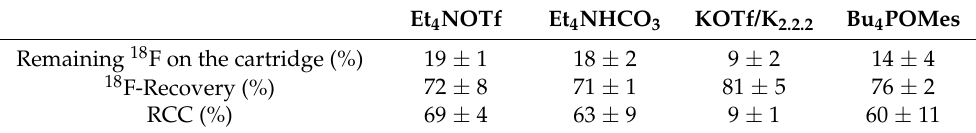
Table 1. 18 F-Recovery and radiochemical conversions (RCCs) of [ 18 F]FPh using different salts in n BuOH. Conditions: [ 18 F]Fluoride (~50 MBq) was loaded onto a QMA cartridge from the male side. The cartridge was washed with n BuOH (1 mL) in the same direction and flushed with air (5 mL). Afterwards 18 F – was eluted from the female side with a solution of the respective salt (11 µ mol) in n BuOH (300 µ L). A solution of PhSnMe 3 (14.5 mg, 60 µ mol) and Cu(py) 4 (OTf) 2 (20.3 mg, 30 µ mol) in DMA (700 µ L) was added, the reaction mixture was heated at 100 ◦ C for 10 min (300 µ L) under air, diluted with H 2 O (1 mL) and analyzed by HPLC. All experiments were carried out in triplicate. Et 4 NOTf Et 4 NHCO 3 KOTf/K 2.2.2 Bu 4 POMes Remaining 18 F on the cartridge (%) 19 ± 1